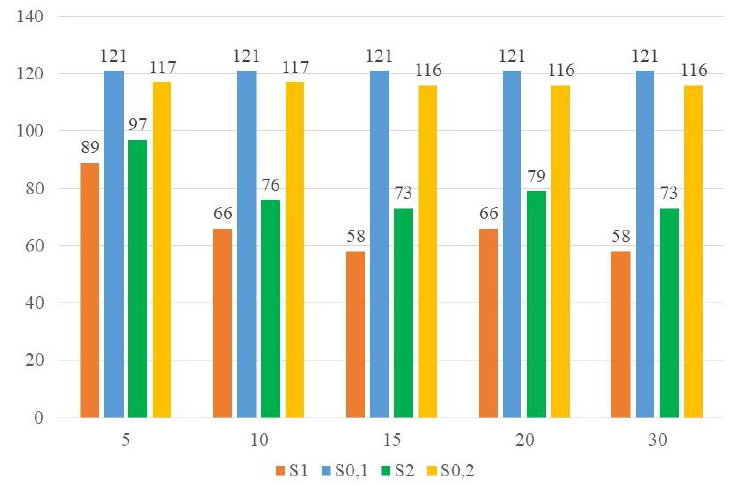
Figure 2. Results from the LCOW analysis of Scenario 0, 1, and 2, for Nc from 5 to 30.